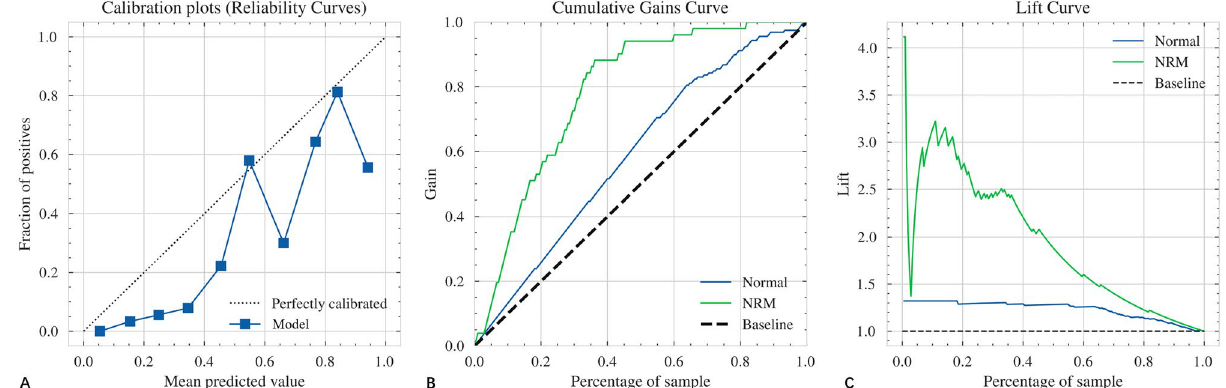
Figure 1. The calibration plots, gain curve and lift curve of machine-learning model built by RUSBoost architecture for predicting the possibility of NRM. ( A ) Calibration plots; ( B ) gain curve; ( C ) lift curve. RUSBoost random under-sampling with AdaBoost, NRM neonatal respiratory morbidity.